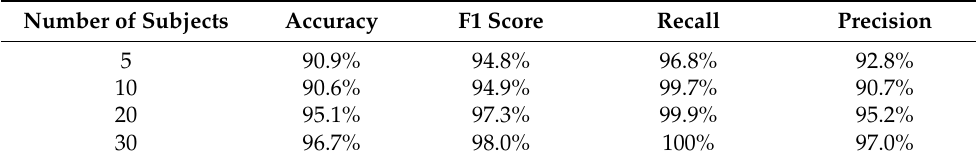
Table 2. UA Bi-LSTM-based system average testing performance metrics in different